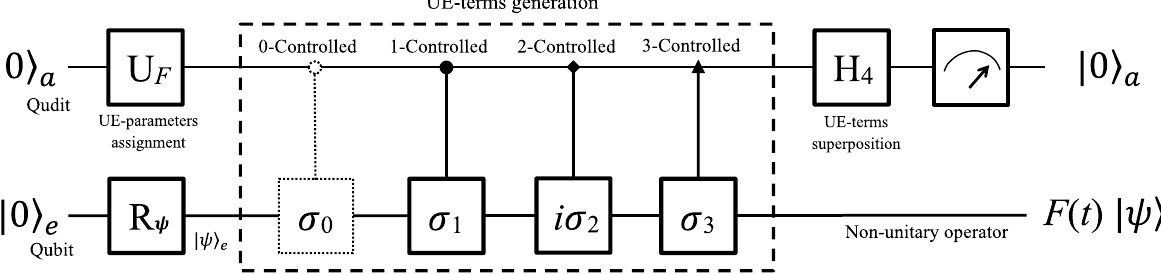
0 0 a e , | � | � ψ e by R ψ . First, | �